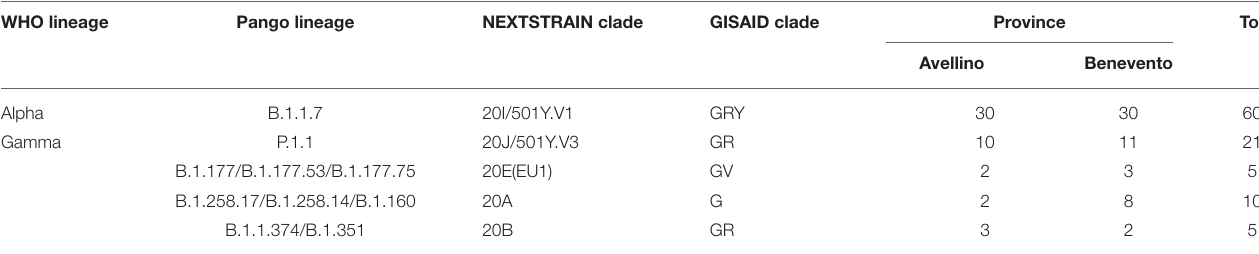
TABLE 1 | Distribution of SARS-CoV-2 samples according to Pango lineage, clade, and WHO lineage. WHO lineage Pango lineage NEXTSTRAIN clade GISAID clade Province Tot